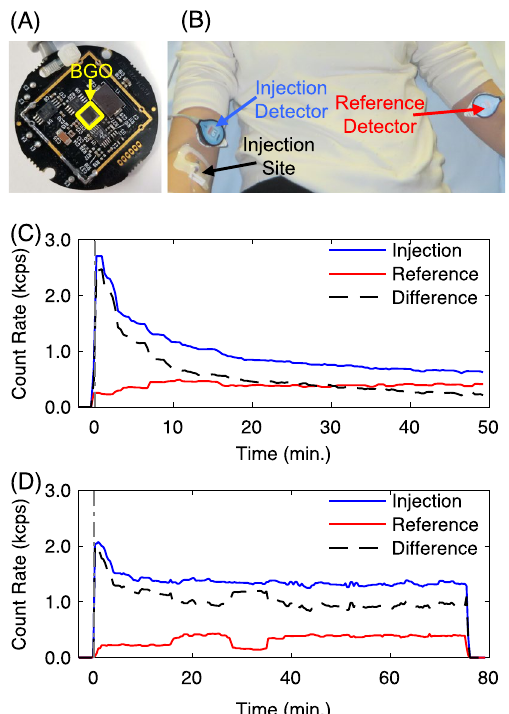
Fig. 1 Overview of the topical detector system used for classifying extravasation severity. A Single detector electronics that include a BGO scintillator coupled to a silicon photomultiplier and ( B ) placement of the two system detectors on the subject’s injection and contralateral arms; injection and reference detectors, respectively. C , D Representative TACs demonstrating signals from the injection and reference detectors, and their difference for subjects ( C ) with negligible and ( D ) moderate